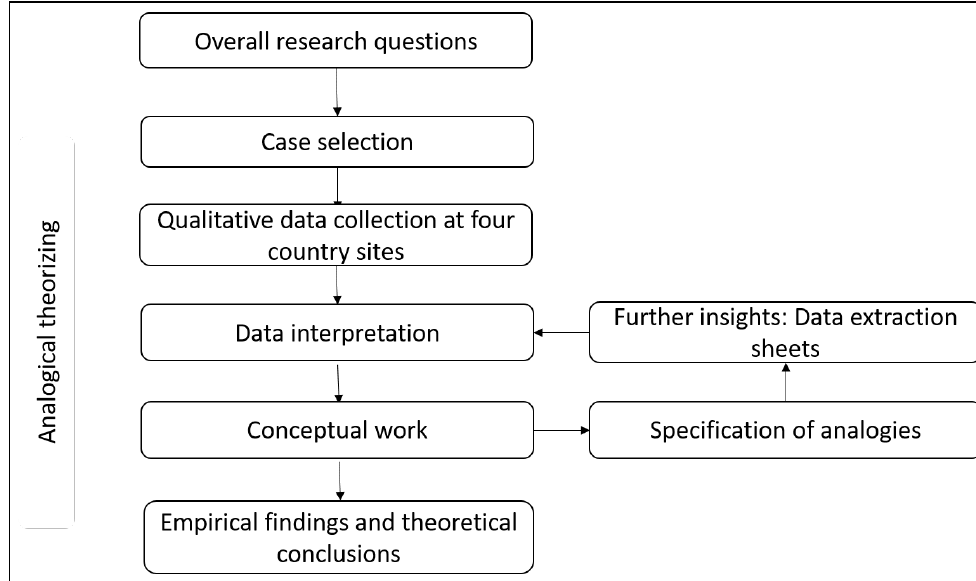
Figure 1. Outline of research process.